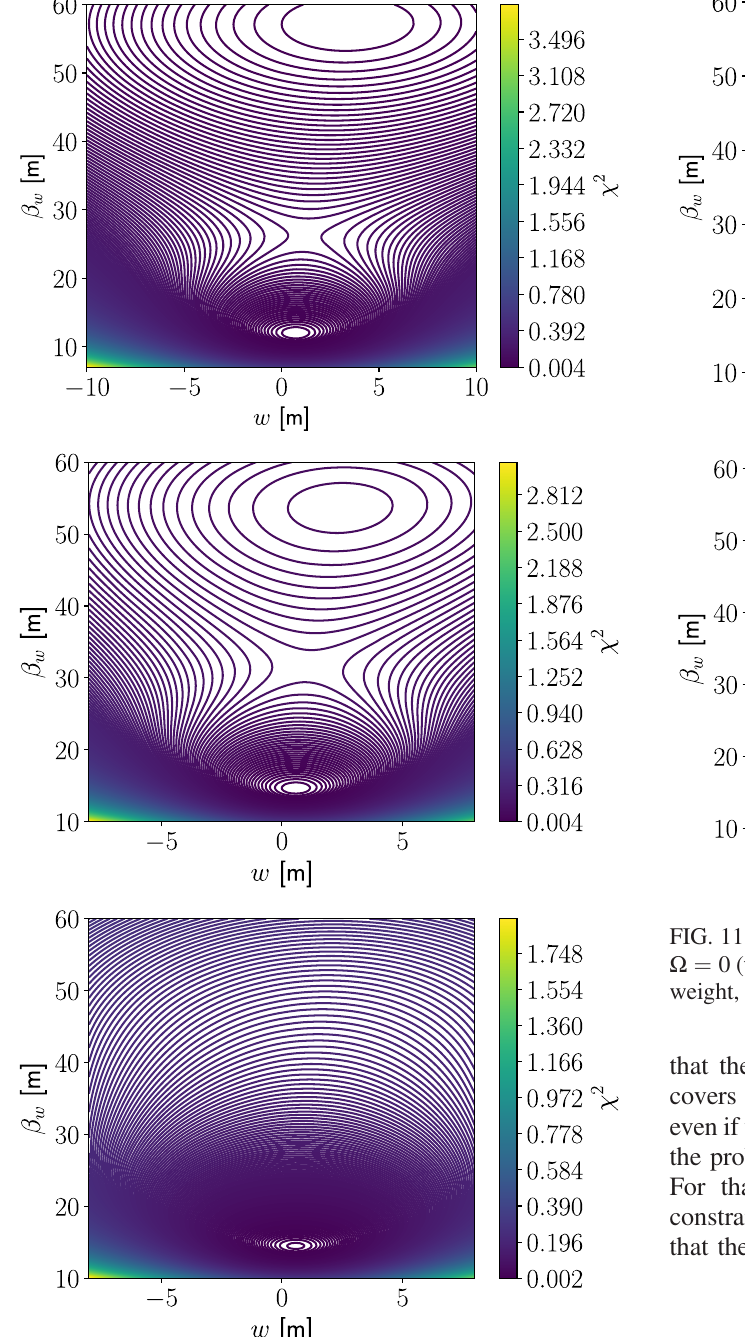
FIG. 10. Scans over w and β w and the figure of merit value obtained for different phase advance weights: Ω ¼ 0 (top), Ω ¼ 0 . 2 (middle), and Ω ¼ 0 . 5 (bottom) for LHC injection optics.